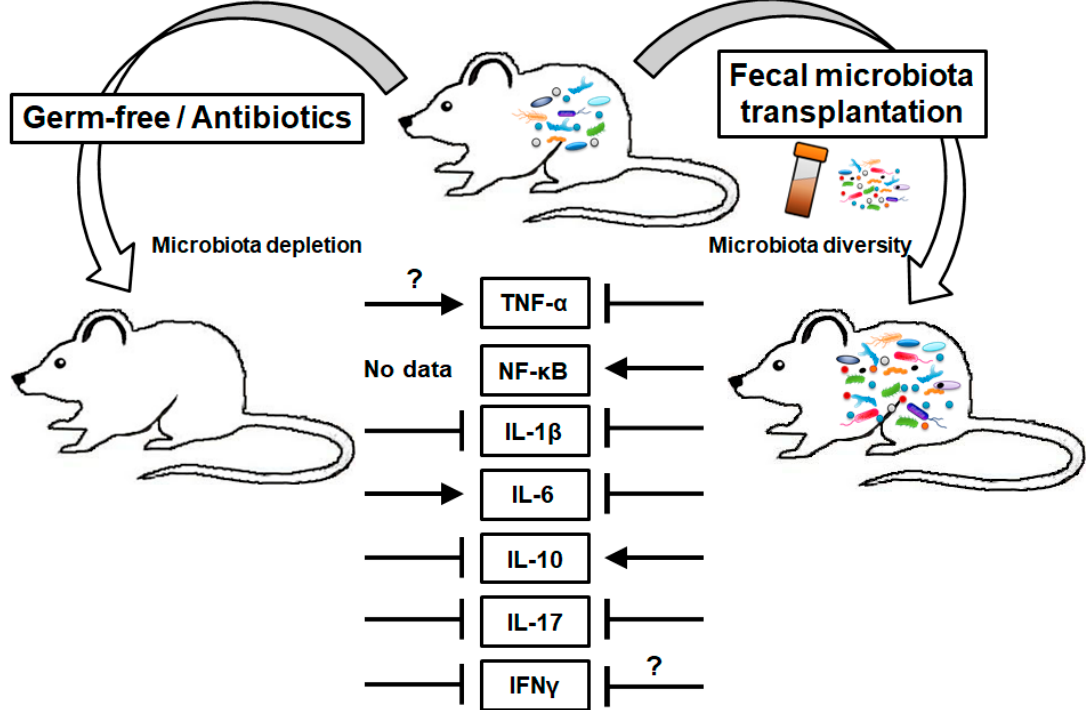
Figure 2. Effects of gut microbiota modulation on the production of inflammatory mediators. ?,